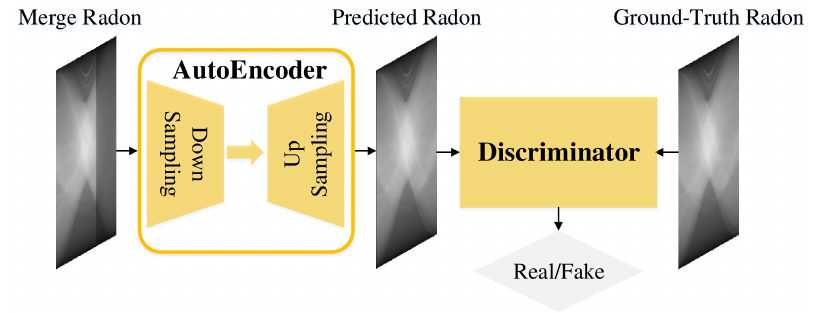
Figure 3. The overall architecture of our proposed AAE in stage one.